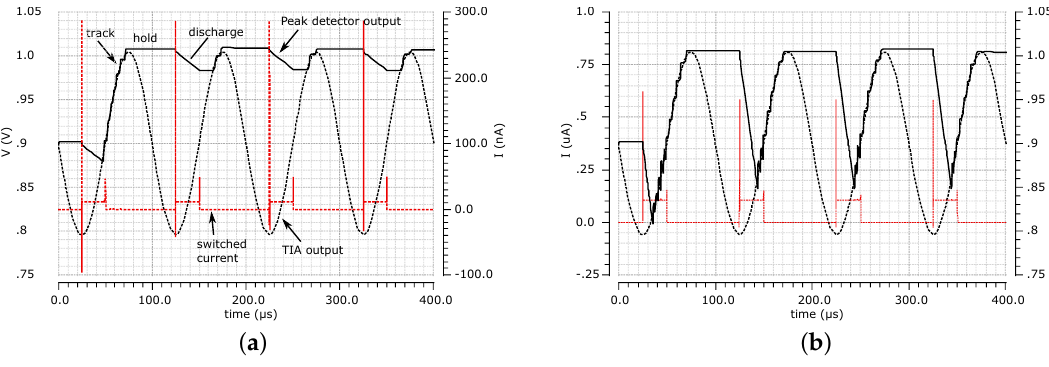
Figure 7. Transient simulation of the adaptive PD unit at 10 kHz. The relaxation current is set to ( a ) 10 nA and ( b ) 100 nA and switched at the same frequency as the input signal with a 25% duty cycle. The output capacitor of the PD (external) is 300